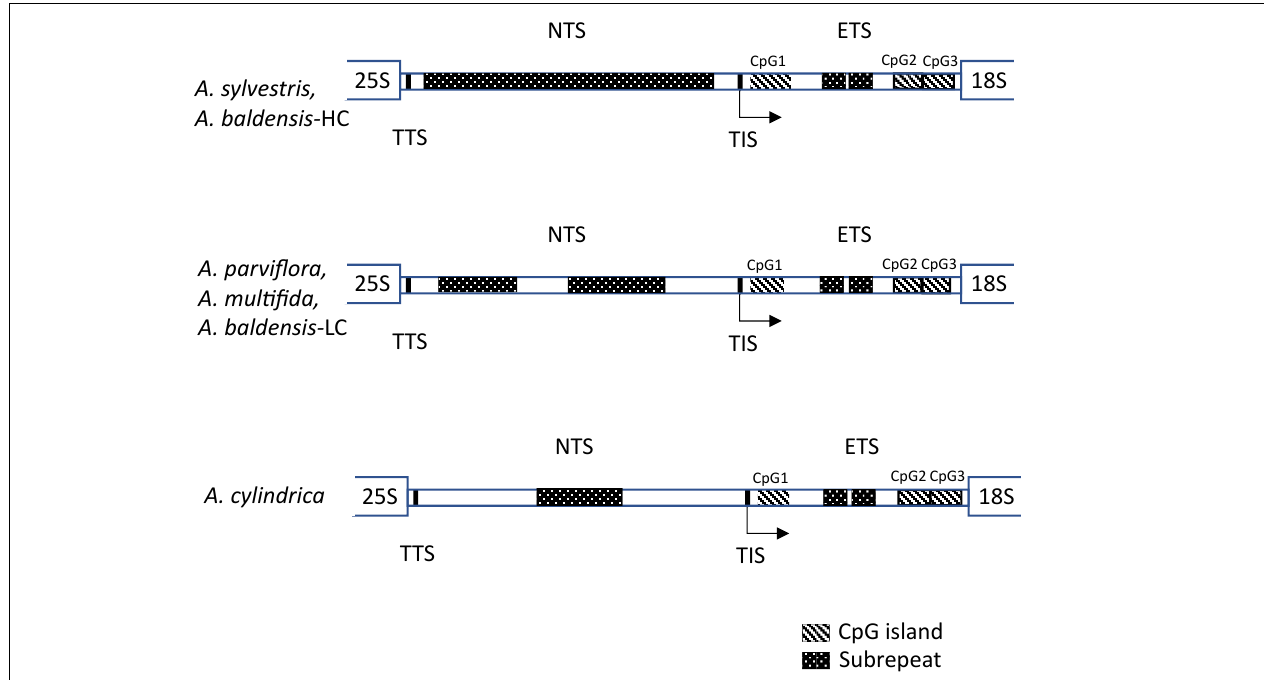
FIGURE 3 | Structural organization of the IGS in Anemone and position of CpG1, CpG2 and CpG3 islands. IGS-intergenic spacer; ETS-external transcribed spacer; TTS-transcription termination site; NTS-non-transcribed spacer; TIS-transcription initiation site. TABLE 3 | Pairwise identity matrix for two Intragenic spaces regions (IGS), Non-transcribed spacer (NTS) above the diagonal (gray background) and external transcribed spacer (ETS) below the diagonal (blue background) of five Anemone species and their IGS variants identified in this study. Pairwise identity